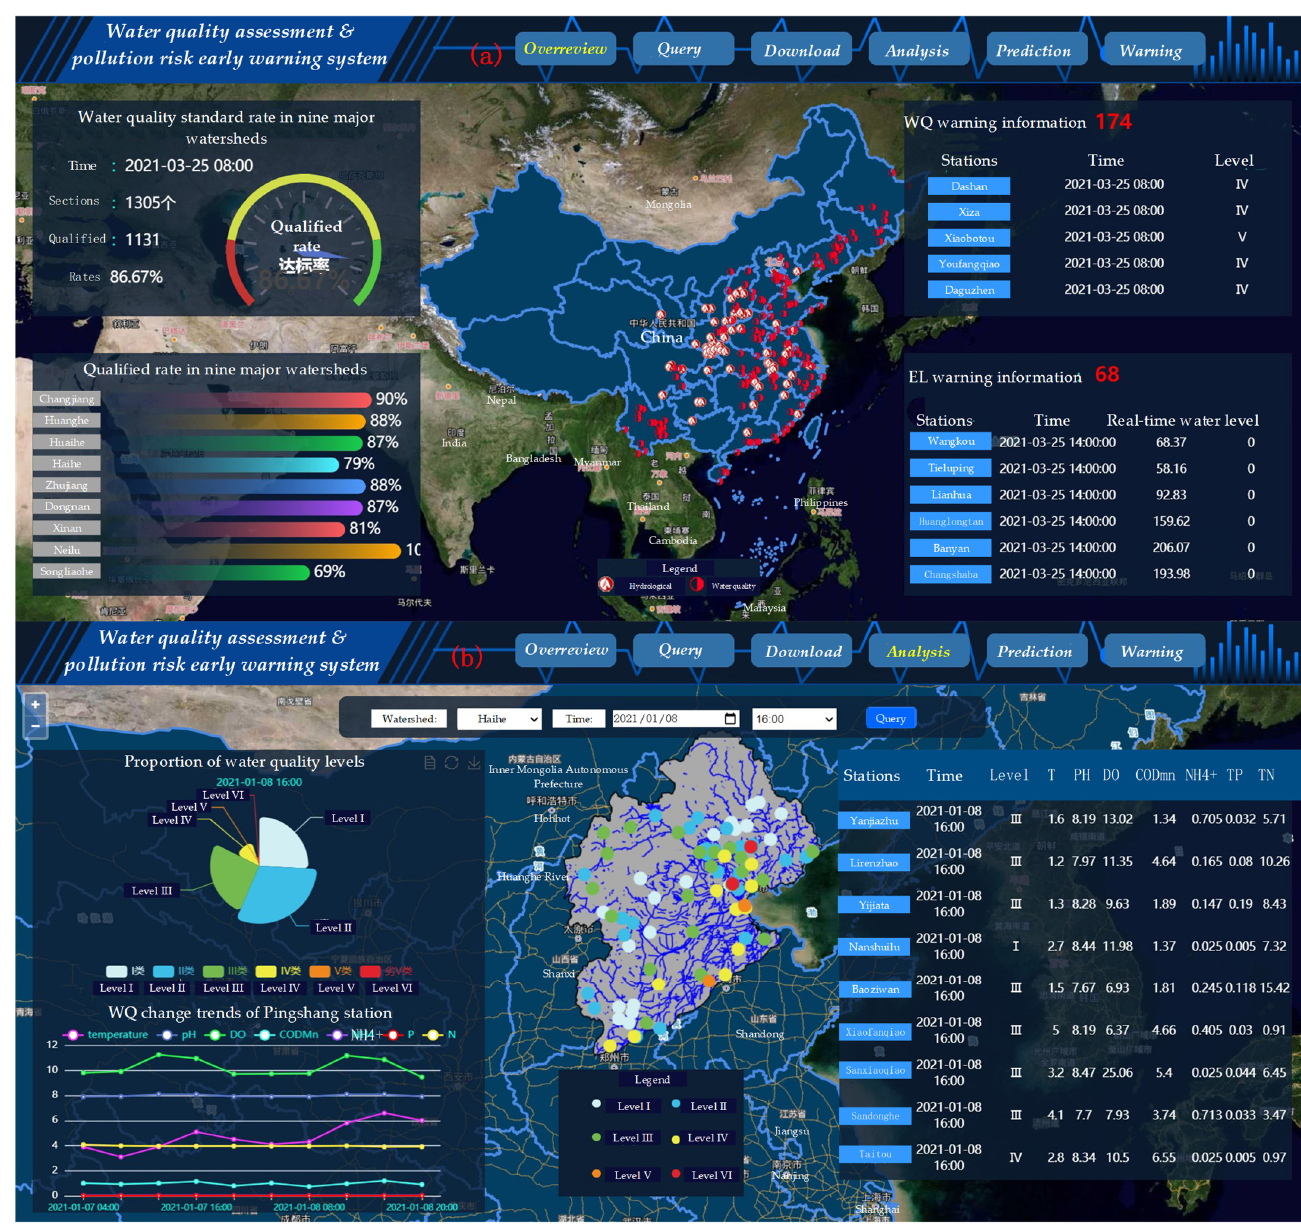
Figure 9. Functions of the water environment data sharing and analysis system (( a ): overview of water-environment-monitoring data, ( b ): water quality analysis). Level VI of water quality means the water quality is worse than level V.